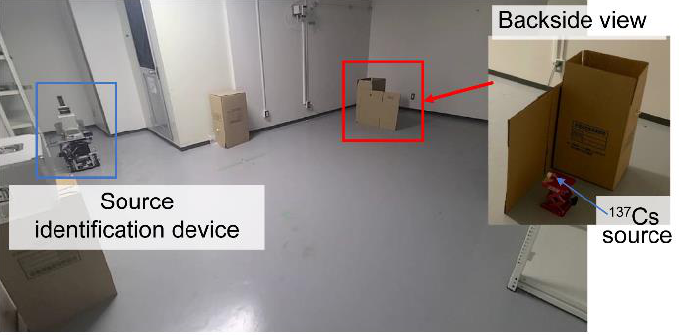
Figure 7. Top view of the room map obtained by simultaneous localization and mapping (SLAM) with the locations of the source and measurement points.